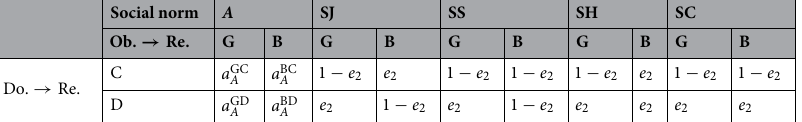
Table 2. Probabilities with which an observer assigns a good reputation to a donor, given the donor’s action toward the recipient and the observer’s evaluation of the recipient at the present time. Rows indicate whether the donor chooses to cooperate (C) or defect (D) with the recipient, and columns indicate whether the observer assigns a good (G) or bad (B) reputation to the recipient at the present time step.